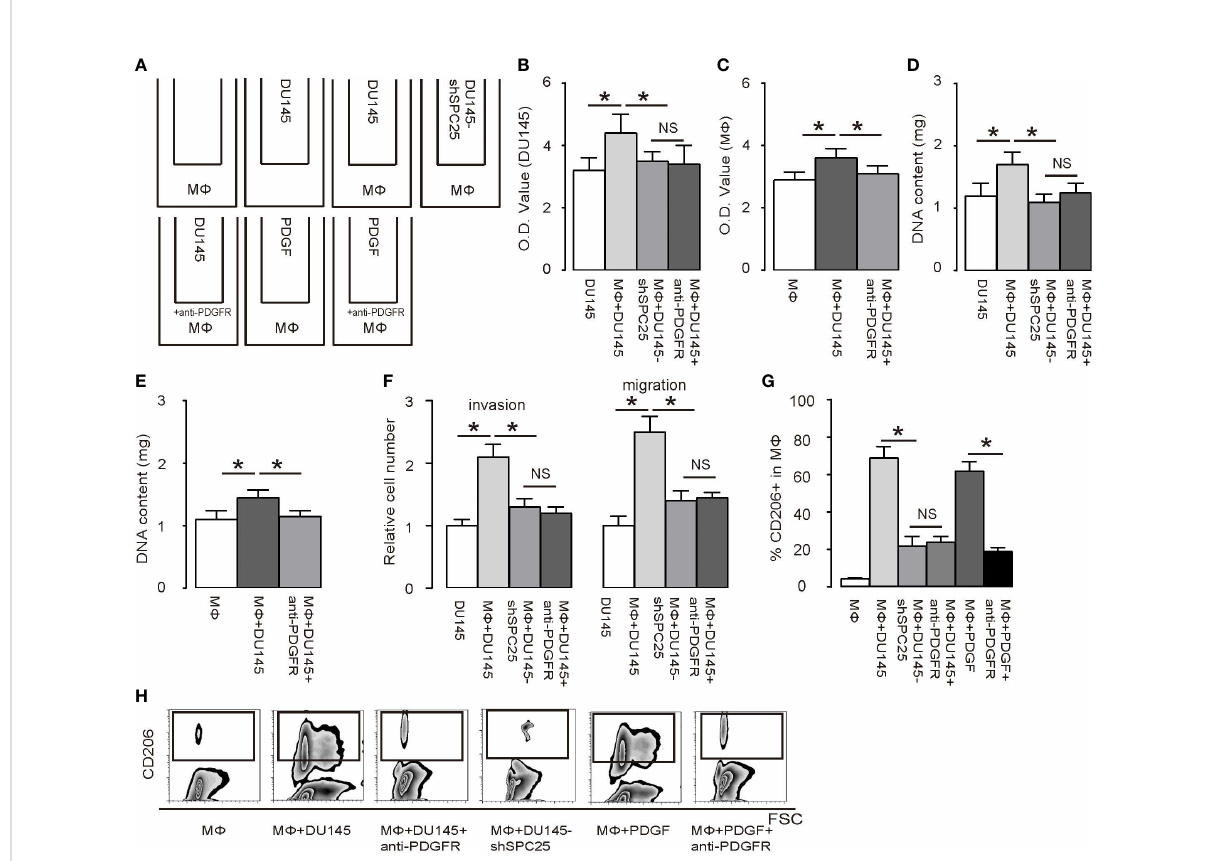
FIGURE 4 PrC cells regulate macrophage polarization, which, in turn, mediates PrC cell growth (A) A diagram of a transwell co-culture system for DU145 cells and bone-marrow-derived macrophages (M F ). Group 1: macrophages alone; Group 2: DU145 cells alone; Group 3: co-culture of macrophages and DU145; Group 4: co-culture of macrophages and DU145-shSPC25; Group 5: co-culture of macrophages and DU145 with presence of an anti-PDGFR antibody; Group 6: macrophages alone with presence of PDGF; Group 7: macrophages alone with presence of PDGF and the anti-PDGFR antibody. Cells were incubated for 2 days. (B, C) An MTT assay was performed in DU145 cells (B) and in macrophages (C) . (D, E) DNA content determination on DU145 cells (D) and in macrophages (E) . (F) Cell invasion and migration in macrophages. (G, H) Flow cytometry analysis of CD206+ cells in macrophages, shown by quanti fi cation (G) and by representative fl owcharts (H) . * p < 0.05. NS, non-signi fi cant. n =